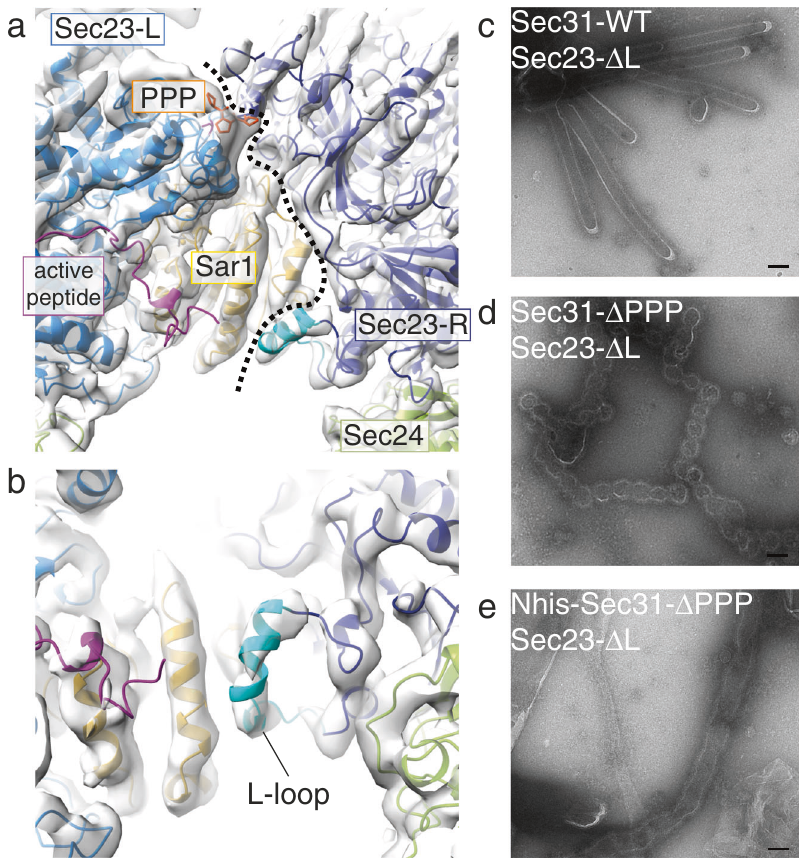
Fig. 6 Interface between inner coat subunits. a The interface between neighbouring inner coat subunits viewed from the top. A dotted line de fi nes the boundary between two protomers. b Enlarged view of the Sec23-Sar1 interface, with the modelled Sec23 17-residue L-loop in dark cyan. This loop is disordered in the X-ray structure, but becomes ordered in the lattice, mediating interactions with Sar1. Sigma threshold for contouring was set at 0.08 for ( a , b ). c GUV budding reconstitutions in the presence of wild-type Sec31 and Sec23 lacking the L-loop show straight tubules, similar to wild-type reactions. d Budding creates spherical pro fi les when Sec31 has all of its PPP sites mutated to alanine to further weaken inner coat assembly. e Floppy tubules form when, in addition to the conditions in ‘ d ’ , Sec31 vertex interactions are destabilised with Nhis-Sec31. Scale bar 100 nm. Micrographs in ( c – e ) are representative of experiments repeated at least three